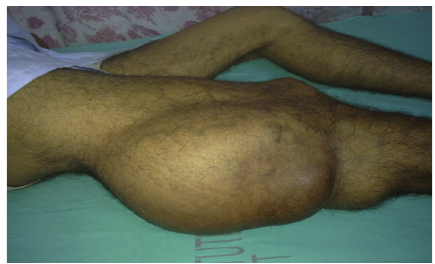
Figure 1: Clinical photograph showing cystic mass extending from knee to upper one-third thigh on posterolateral aspect.